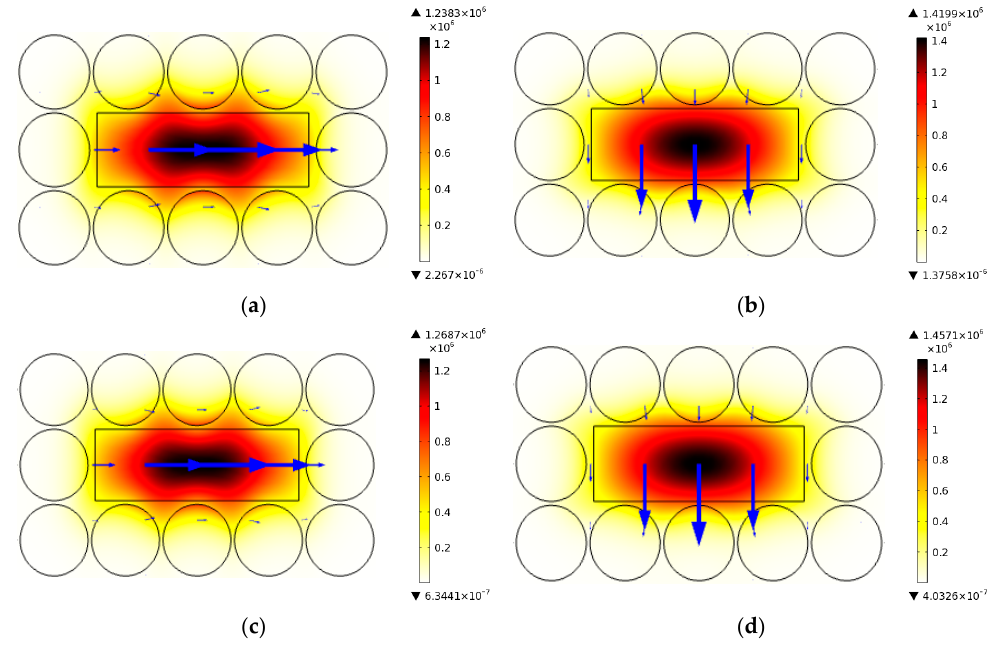
Figure 2. Electric field distribution of the fundamental mode at 2.8 THz: ( a ) x -polarization, petrol; ( b ) y -polarization, petrol; ( c ) x -polarization, kerosene; ( d ) y -polarization, kerosene.